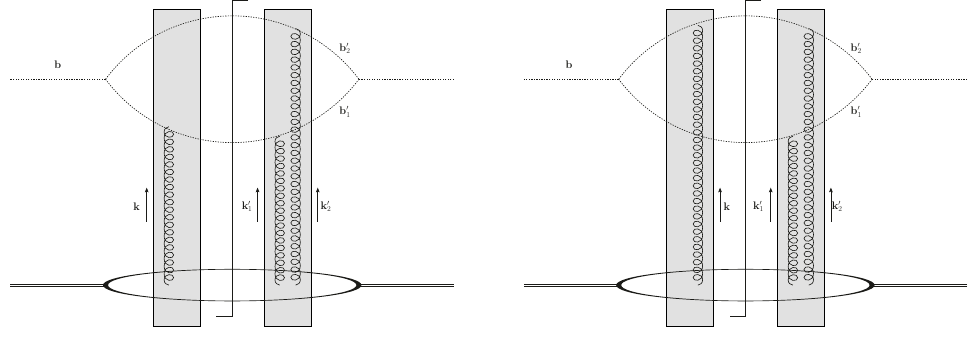
Figure 2 . 3-body contributions with 2 gluons in the complex conjugate amplitude.